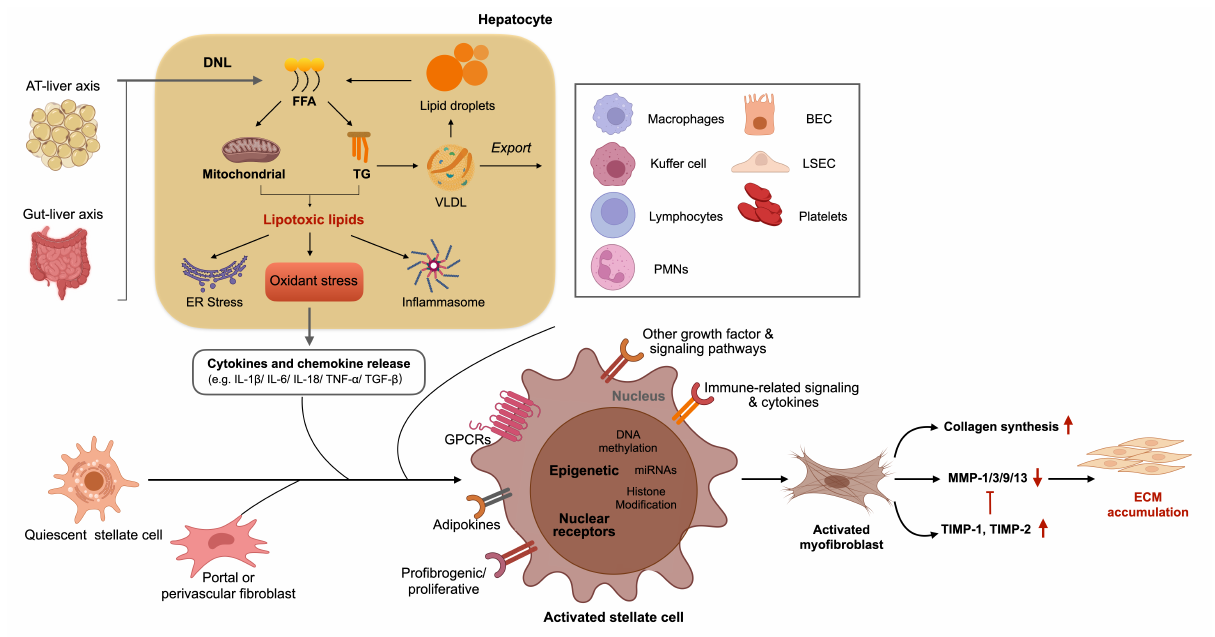
Figure 1. Molecules and mechanisms of liver